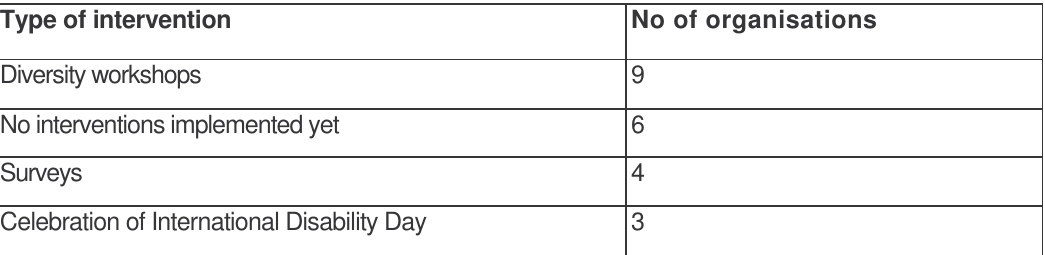
Table 9: Types of interventions implemented Type of